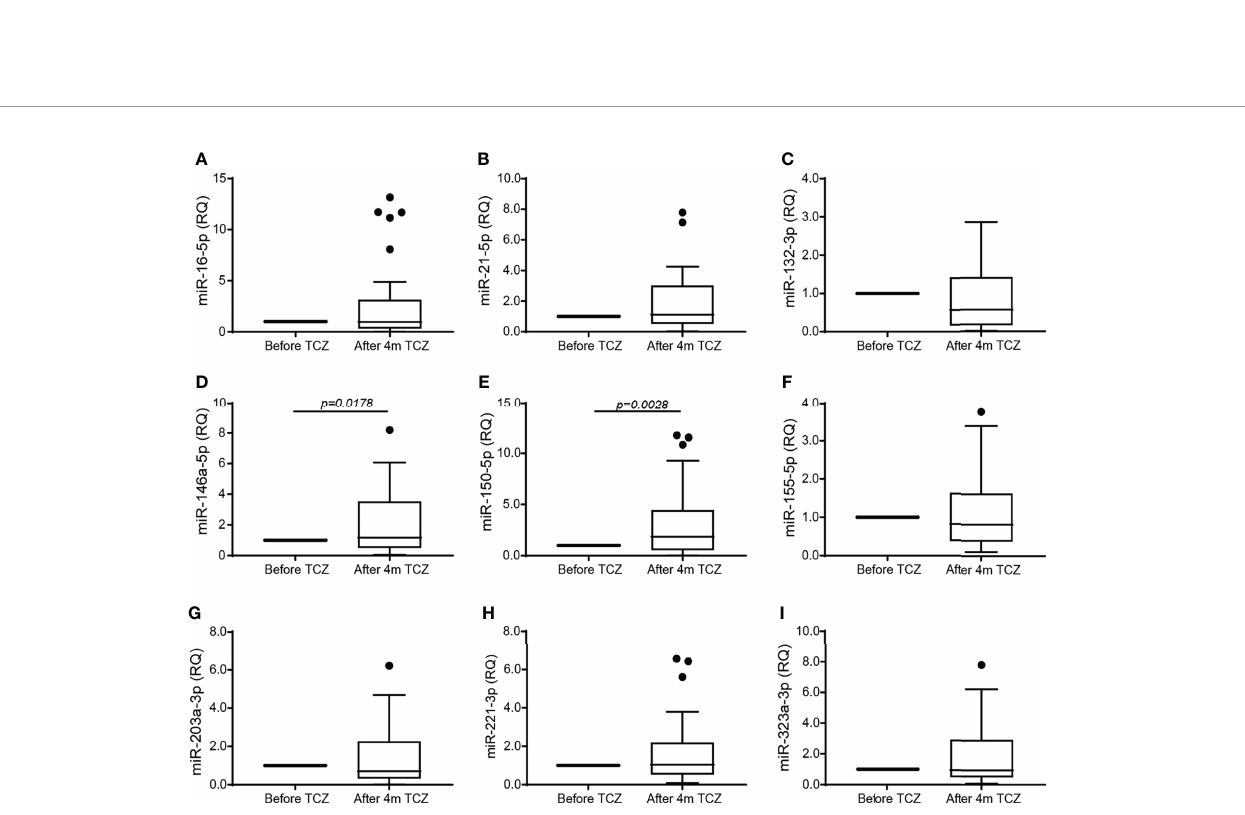
FIGURE 3 | TCZ treatment increases the serum expression of miR-146a-5p and miR-150. Total RNA was extracted from serum samples before and 4 months after initiation of TCZ treatment, and the expression levels of 9 different microRNA known to be involved in angiogenesis and in RA were determined using comparative CT method for relative quanti fi cation, where each patient served as its own control. (A) miR-16-5p, (B) miR-21-5p, (C) miR-132-3p, (D) miR-146a-5p, (E) miR-150-5p, (F) miR-155-5p, (G) miR-203a-3p, (H) miR-223-3p, (I) miR-323a-3p. The Wilcoxon matched-paired signed rank test was used to compare between the concentrations of each of the cytokines before and 4 months after TCZ treatment